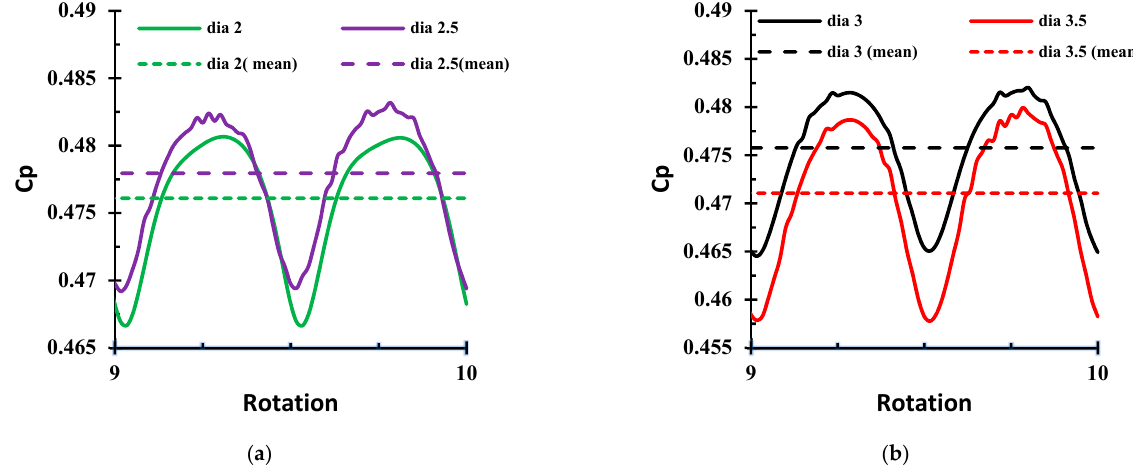
Figure 5. Coefficient of performance for tower having diameter ( a ) 2 and 2.5 m ( b ) 3 and 3.5 m.